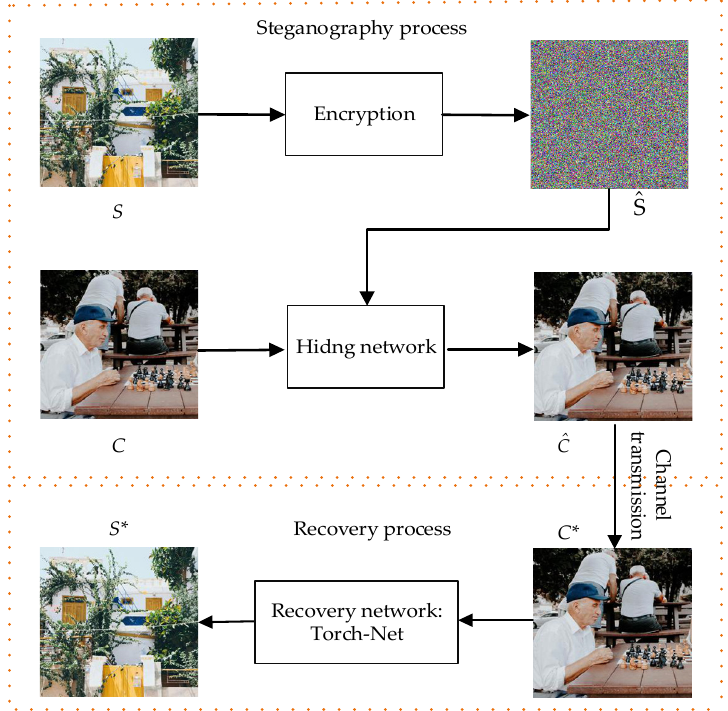
Figure 2. Steganography algorithm flowchart.